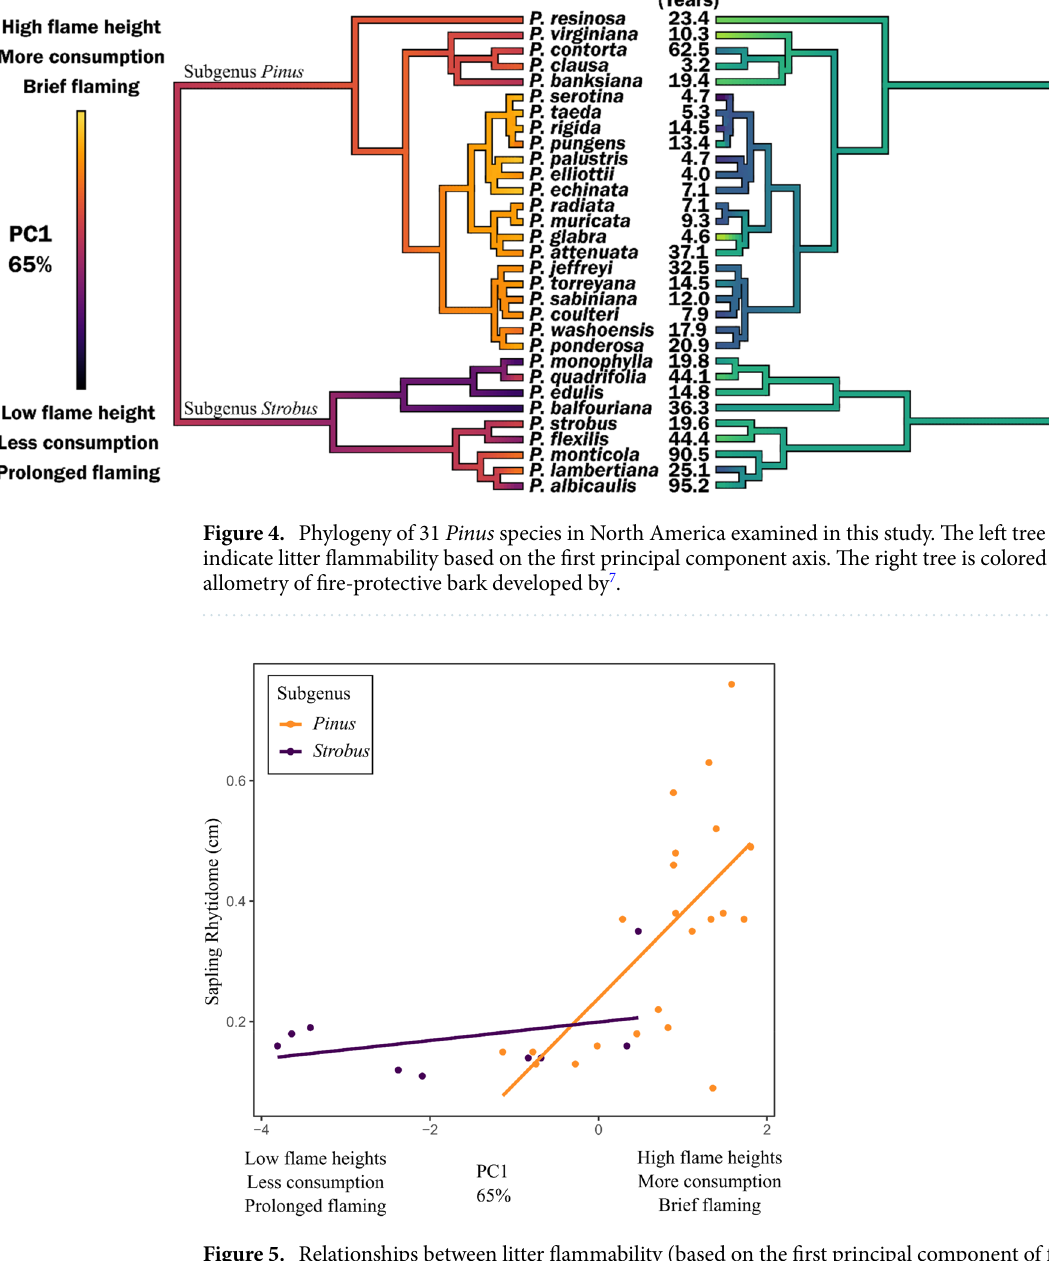
Figure 5. Relationships between litter flammability (based on the first principal component of flammability metrics) and sapling rhytidome thickness (based on allometric equations for a 5 cm diameter stem 7 ) for 31 North American pine